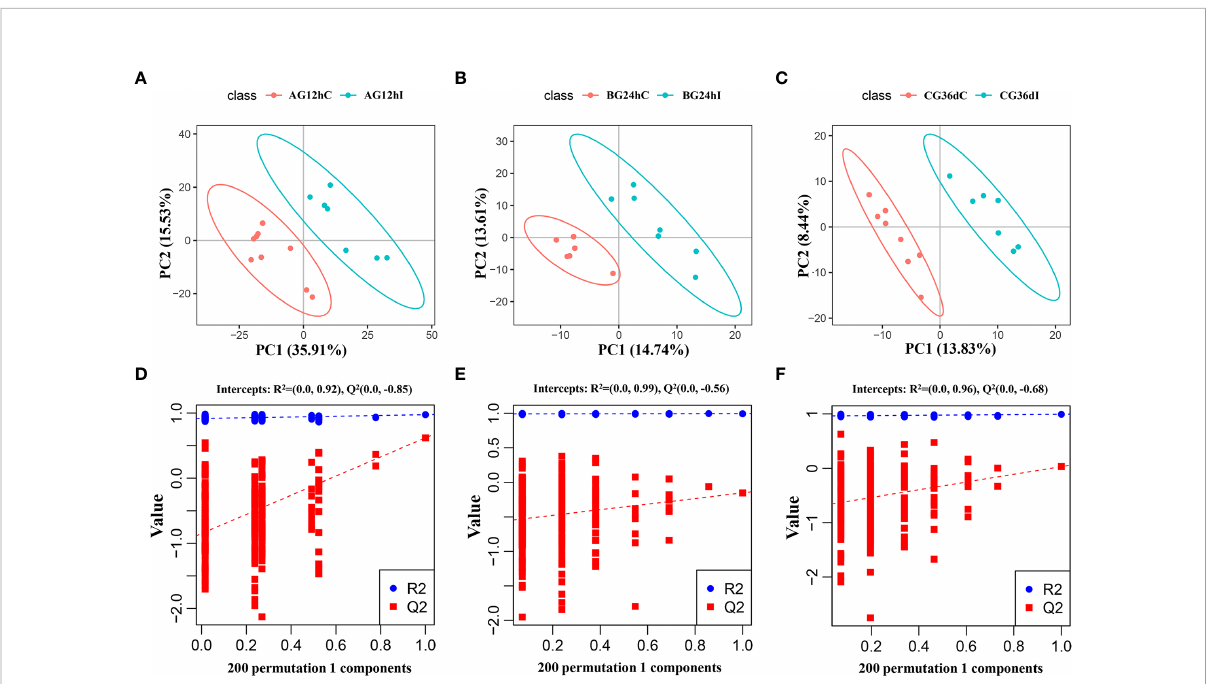
FIGURE 1 The partial least-squares discriminant analysis (PLS − DA) score scatter plots of lipids (A – C) and the response sequencing veri fi cation diagram of the PLS-DA model with 200 permutation tests (D – F) between the infected groups (I) and control groups (C) at 12 hpi, 24 hpi, and 36 dpi, respectively. AG, A group; BG, B group; CG, C